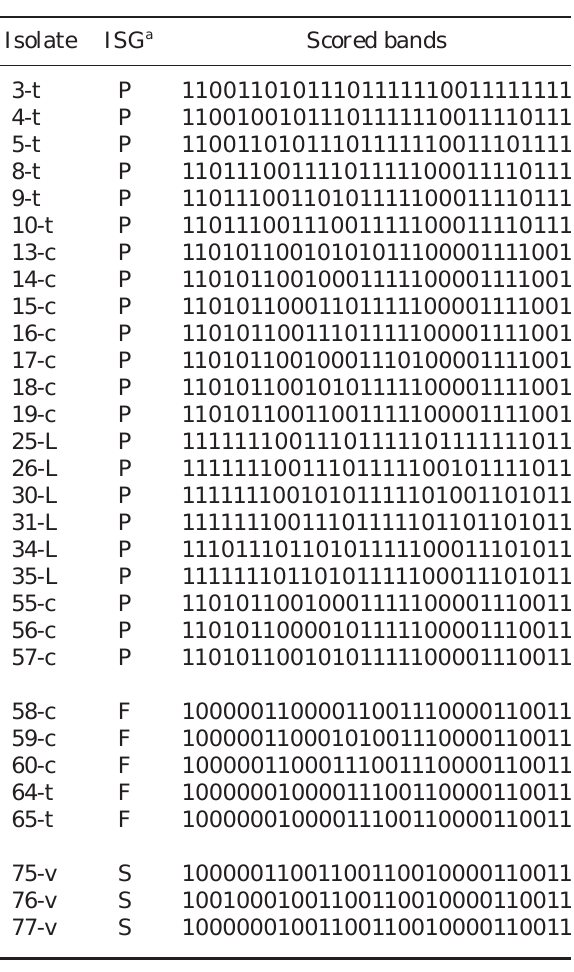
Table 2. Presence-absence band score matrix of Hetero- basidion annosum isolates tested with the M13 primer.